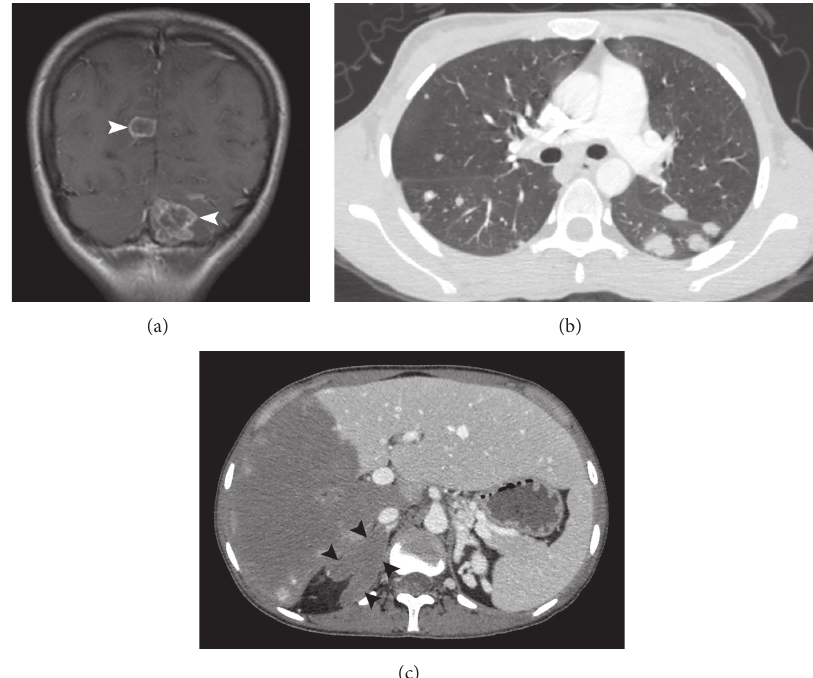
Figure 3: Postcontrast coronal T1-weighted spin echo (SE) image (a) showing irregular peripheral enhancement at the lesions (arrowheads). Chest CT image (b) demonstrates bilateral pulmonary involvement of alveolar hydatid disease. Diffuse right adrenal gland enlargement (arrowheads) is present on contrasted CT (c) compared to the left